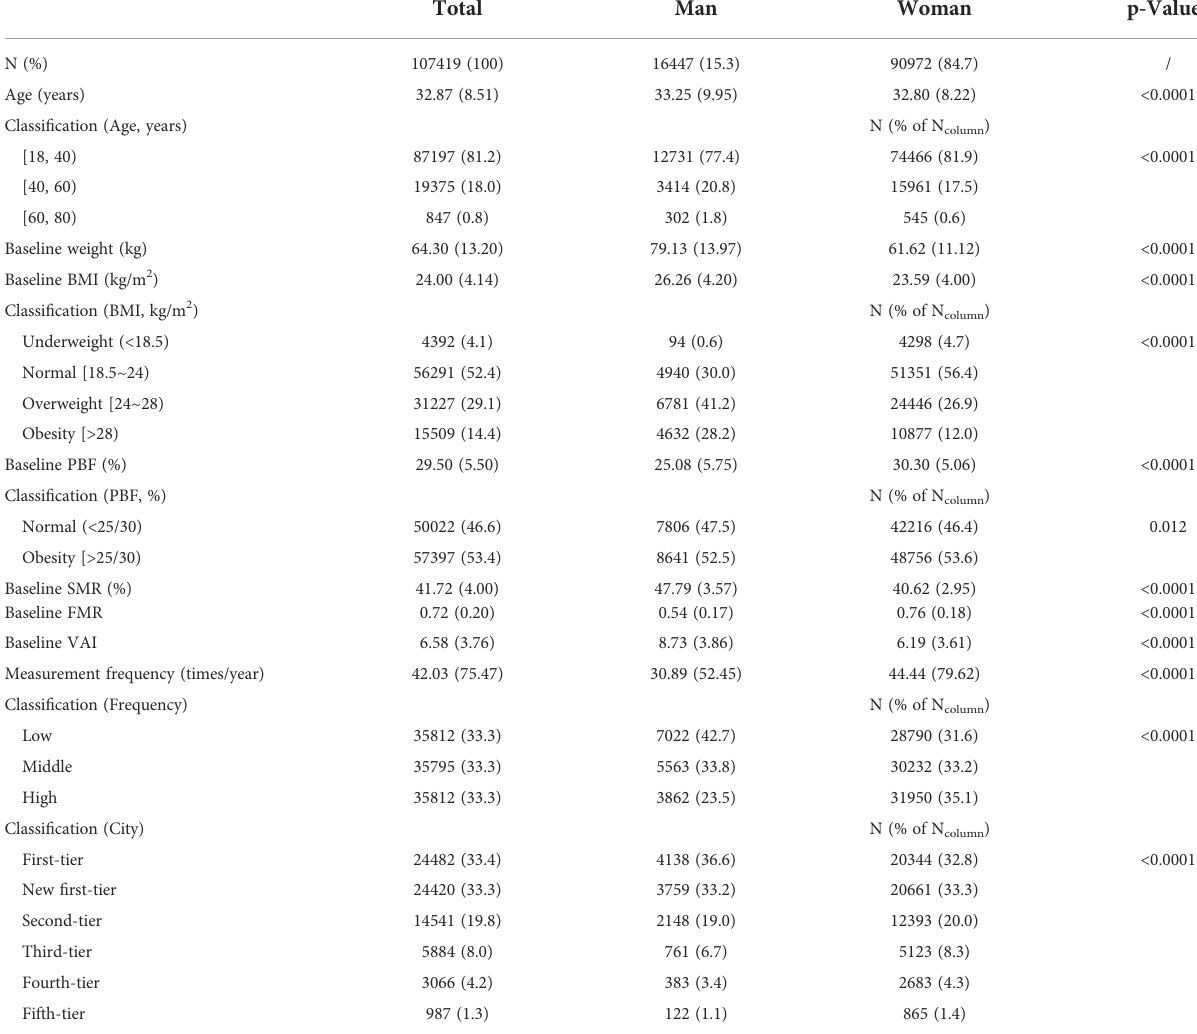
TABLE 1 Baseline characteristics of the participants grouped by gender during the COVID-19 pandemic. Total Man Woman